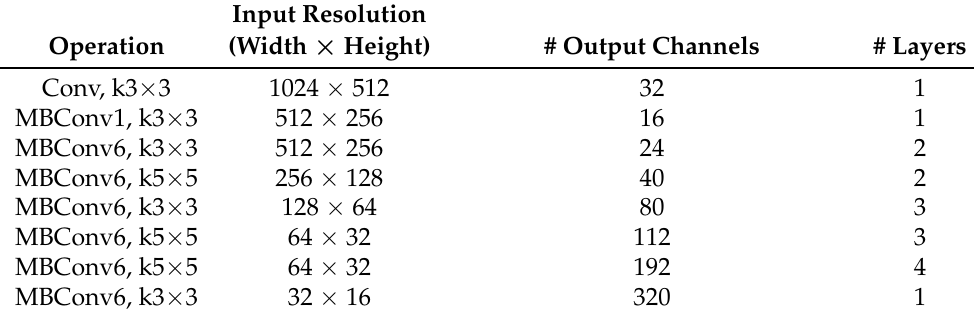
Table 1. Structure and specifications of the modified